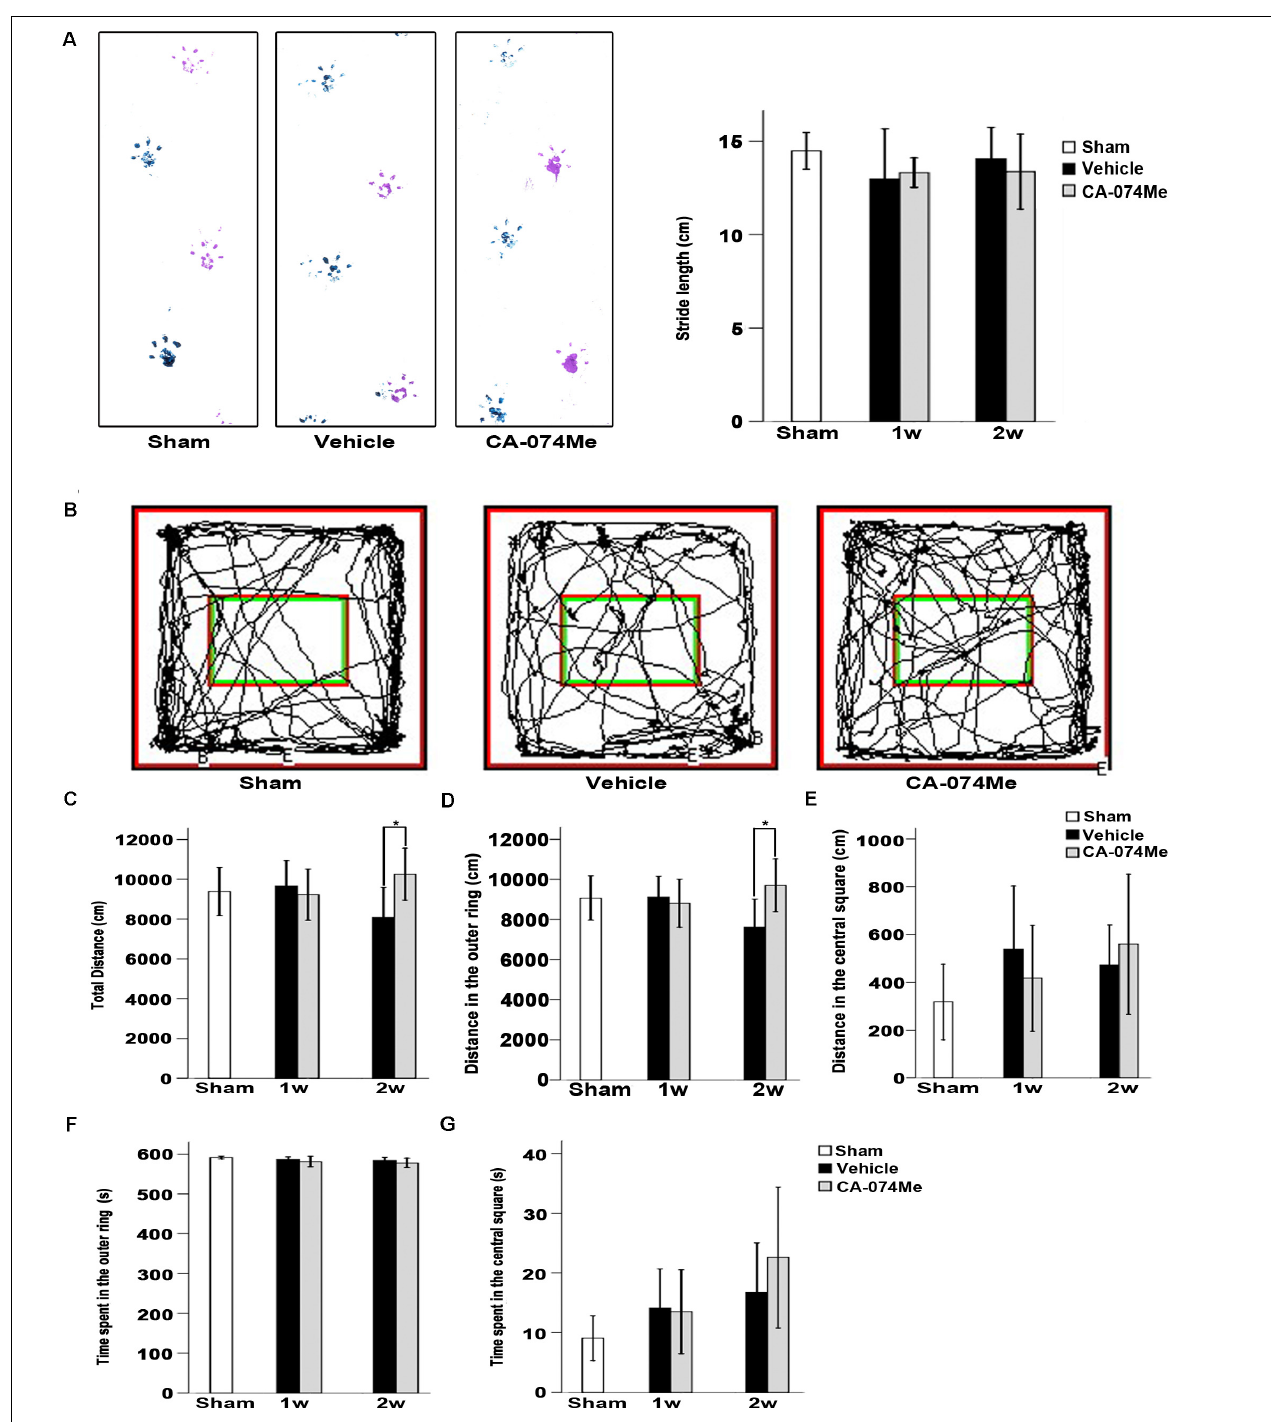
FIGURE 9 | Neurological function evaluation. (A) Typical footprints of animal walking at 2 weeks after dMCAO. Blue: Left forepaw and hindpaw footprints; Purple: Right forepaw and hindpaw footprints; the average footstep length was quantified. Each bar represents the mean ± SD. No statistically differences were observed between vehicle and CA-074Me groups after dMCAO compared to sham-operated group ( n = 10) at 1 week ( n = 7 and n = 9 for vehicle and CA-074Me groups after dMCAO, respectively) and 2 weeks ( n = 9 and n = 8 for vehicle and CA-074Me rats after dMCAO, respectively). (B) Representative tracks for open field test at sham-operated group, vehicle, and CA-074Me group after dMCAO; the total distance traveled (C) and its distance traveled in the outer ring (D) , the central square (E) in sham-operated ( n = 8), vehicle ( n = 7), and CA-074Me ( n = 8) treated rats after dMCAO during 10 min in the open field. The duration of walk in the outer ring (F) and the central square (G) in sham-operated ( n = 8), vehicle ( n = 7), and CA-074Me ( n = 8) treated rats after dMCAO during 10 min in the open field. Each bar represents the mean ± SD. ∗ p < 0.05 versus the vehicle group. Sham; sham-operated; w, week.